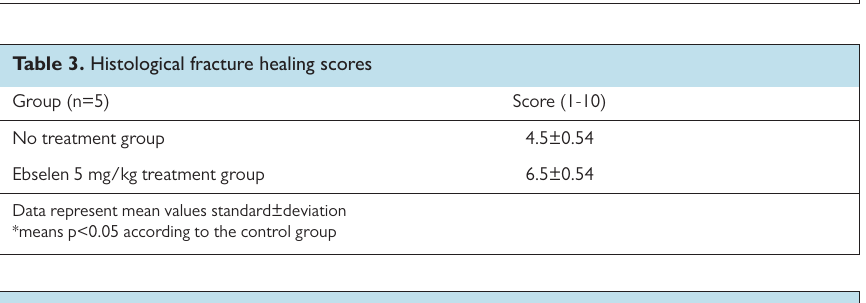
Table 4. VEGF and OC expression scores in groups